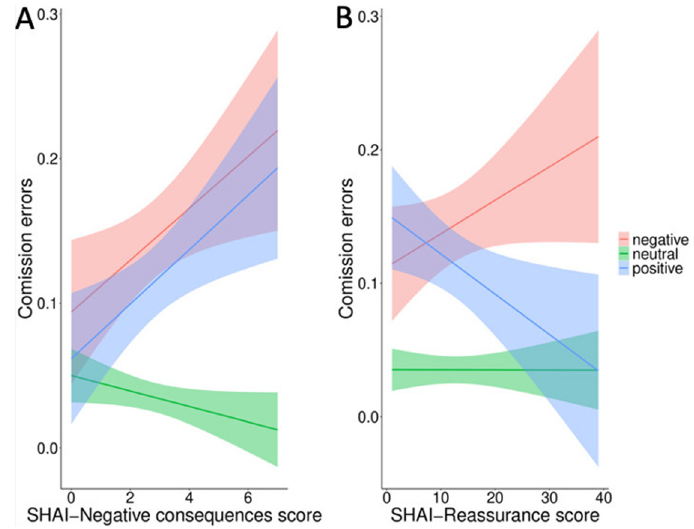
Figure 4. Commission errors for positive, negative and neutral words as function of SHAI-negative consequences ( A ) and SHAI-reassurance scores ( B ).